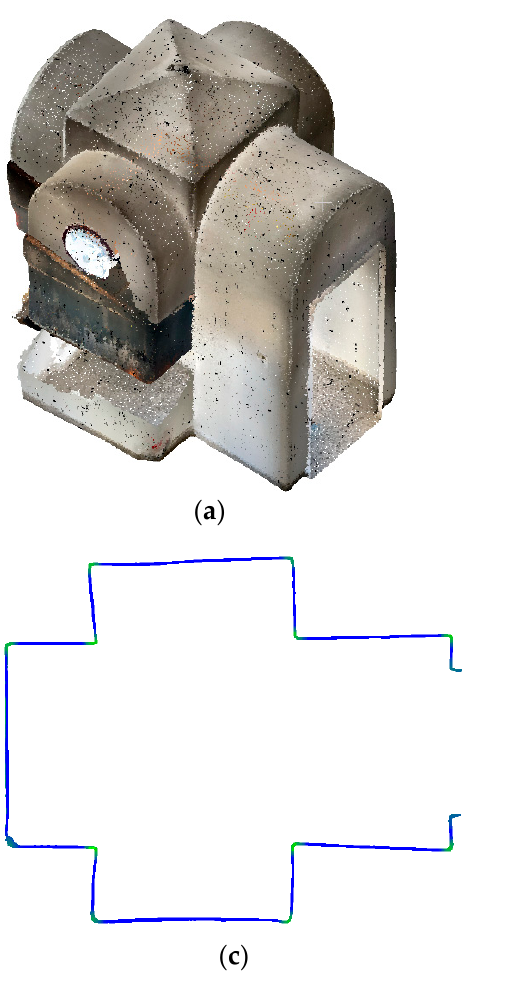
( c ) Figure 15. Scans affected by aberrations; scalar field refers to the surface variation value: steel with 2 cm resolution ( a ), brass with 1.5 cm resolution ( b ), brass with 2 cm resolution ( c ). The planarity values for the Android device are interesting, as this device achieved equal or better results than iOS devices with a lower resolution. The possible deformations of planar surfaces can be better evaluated only in tests performed under dynamic condi- tions. Analyses regarding a linear correlation between albedo and surface variation showed a moderate to very weak relationship. This is another positive element since it indicates that the nature of the material does not primarily affect the quality of the scans. Through tests performed under dynamic conditions, we were able to highlight the